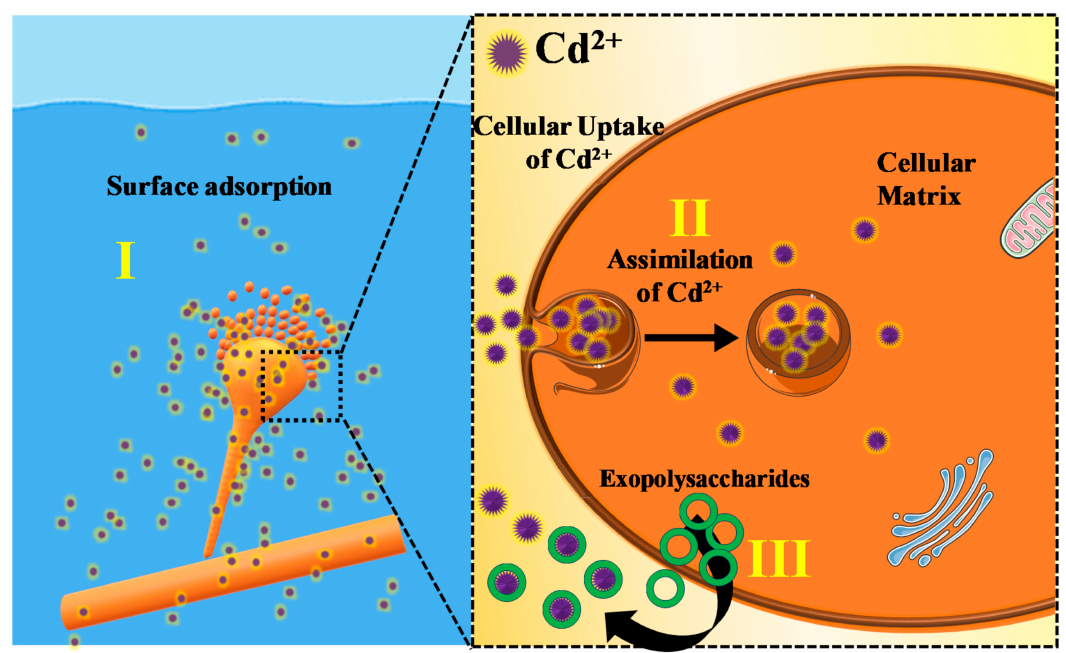
Figure 5. Pictorial illustration of Cd 2 + removal by T. fasciculatum and T.